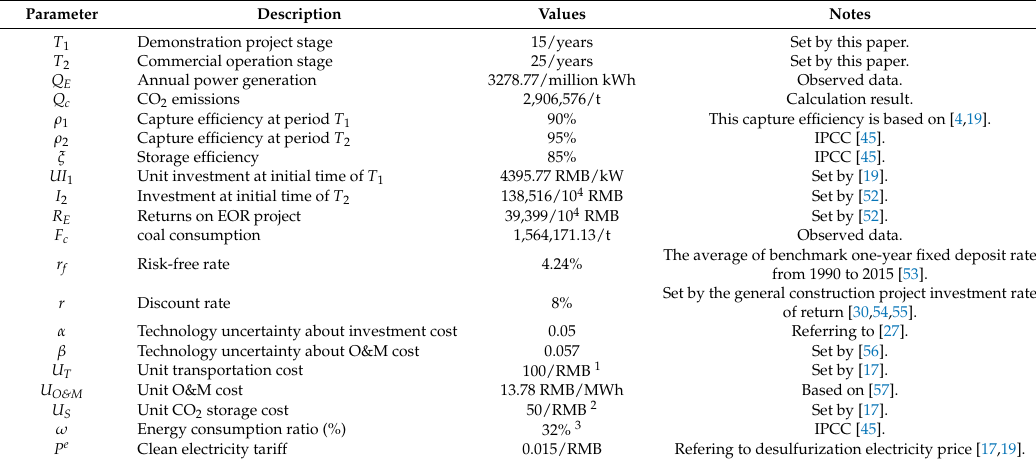
Table 4. Fundamental parameters used in this model.